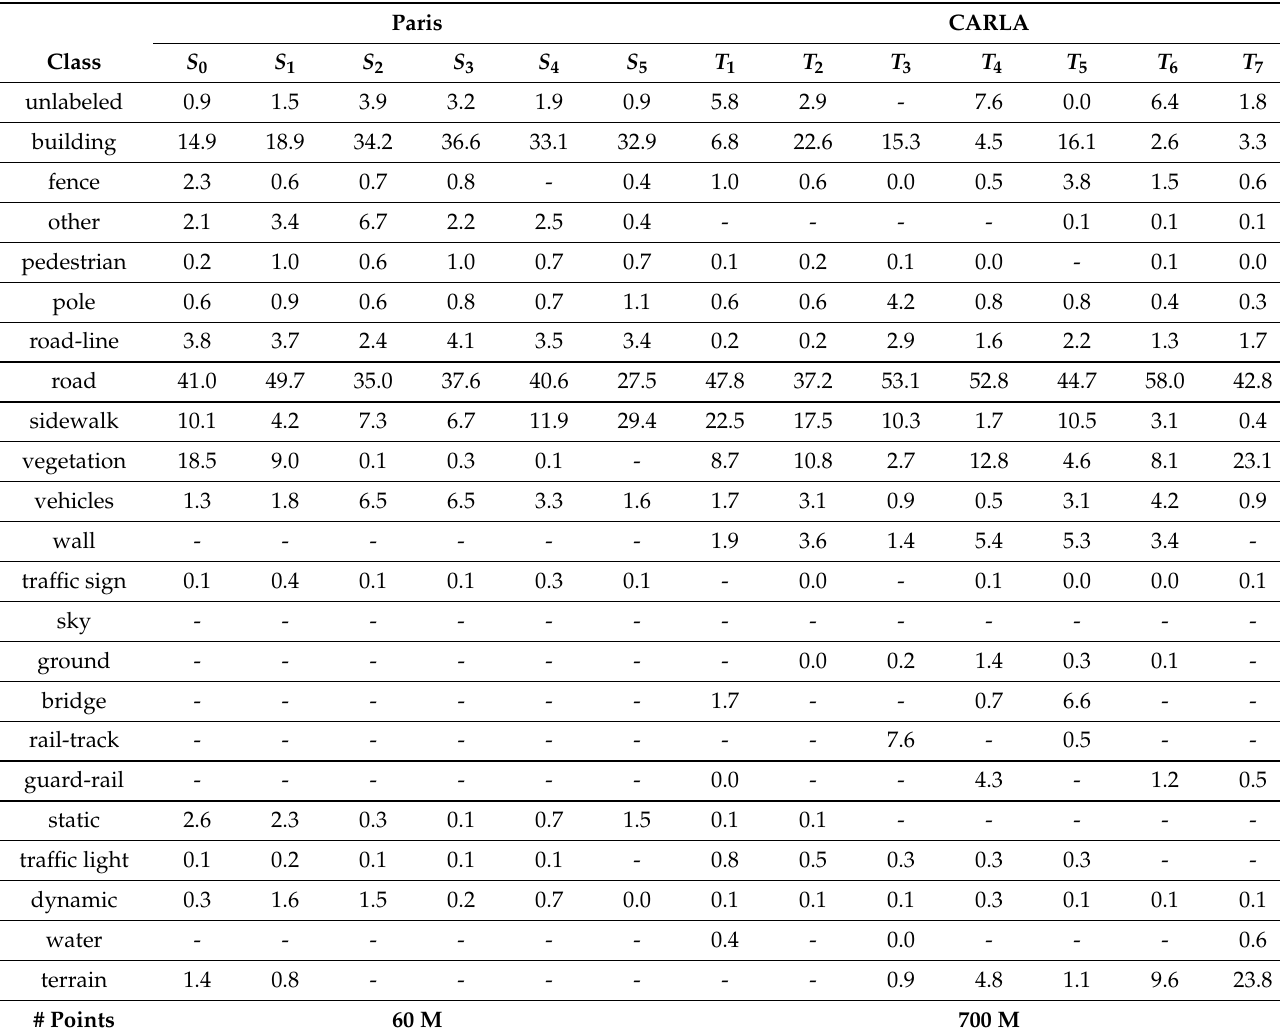
Table A1. Class distribution in Paris-CARLA-3D dataset (in %). Columns headed by S i are Soufflot from Paris data and T j are towns from CARLA data. Paris CARLA